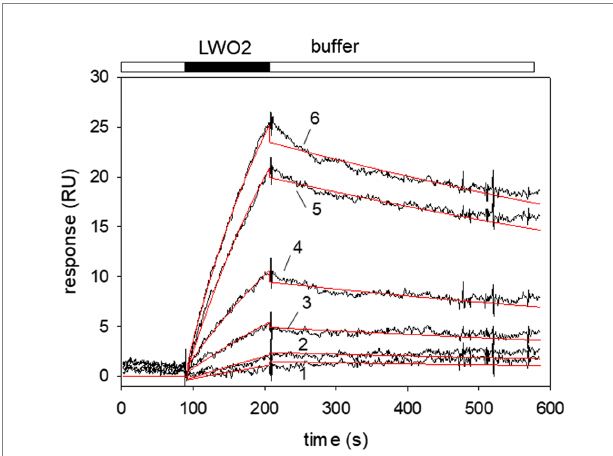
FIGURE 3 Surface plasmon resonance (SPR) recordings of LWO2 interacting with immobilized Gt α /Gi α . Black bar indicates the injection of different peptide concentrations resulting in the association phase, the open bar indicates buffer flow and the dissociation phase, when the injection of the peptide stops. Larger RU values resulted from the injection of higher LWO2 concentrations. Sensorgrams (black lines) obtained after flushing of 5 nM (1), 15 nM (2), 30 nM (3), 50 nM (4), 75 nM (5), and 100 nM (6) LWO2 over immobilized Gt α /Gi α lead to the formation of a LWO2- Gt α /Gi α complex. Global curve fitting (Langmuir 1:1 binding model, red lines) resulted in an association rate constant k a = 5.36 × 10 4 M − 1 s − 1 and a dissociation rate constant k d = 8.12 × 10 − 4 s − 1 , K D = 15.1 nM. The set of sensorgrams is representative of 12 different sets (see main text for mean K D